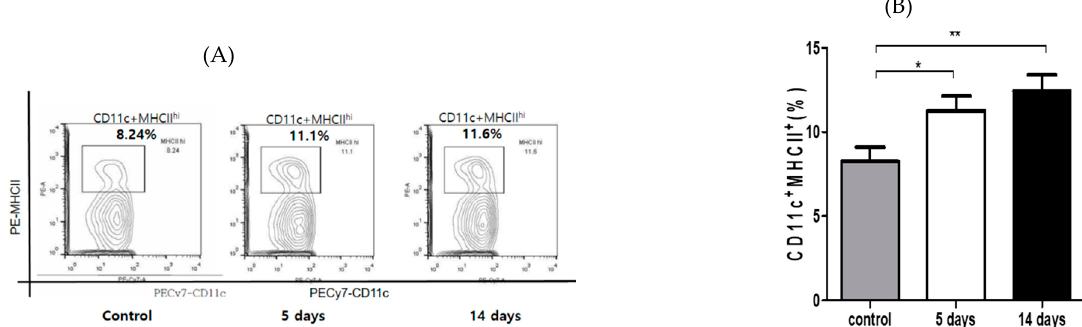
Figure 3. Cytokine expression in the ocular surface. Real-time polymerase chain reaction analysis showed that PM 2.5 exposure significantly increased the relative expressions of TNF (* p < 0.05), IL-6 (* p < 0.05), and IL-1ß (* p < 0.05 and ** p < 0.01) in the corneas, and mucin 5AC (MUC5AC) (* p < 0.05 and ** p < 0.01) in the conjunctivae, compared to the vehicle control groups. Data were normalized to GAPDH mRNA as an internal control, and values were then expressed as the fold change over the normal naive corneas. Data are presented as the mean ± SEM of three experiments. Each experiment consisted of three corneas or conjunctivae per group.